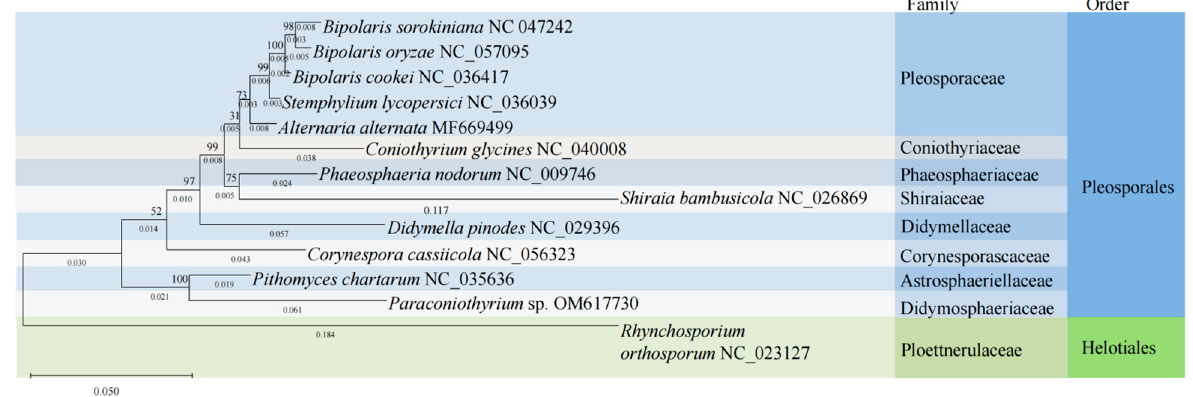
Figure 3. Phylogenetic tree inferred from nucleotide sequences of 12 PCGs using the ML method. Bootstrap support values are indicated on branches.